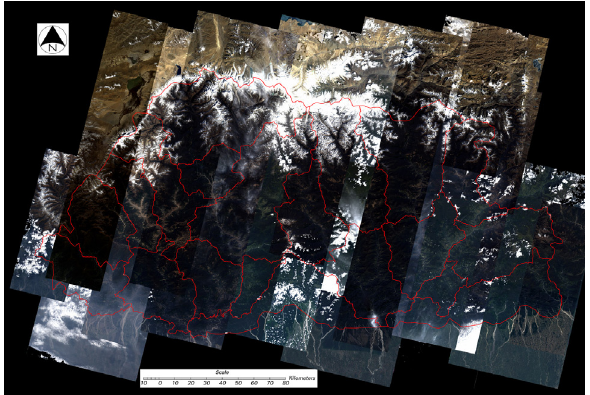
Figure 2. PRISM DSM mosaic in Bhutan with masked areas (black color) and administration boundaries (red). The yellow square represents the magnified area depicted in Figure